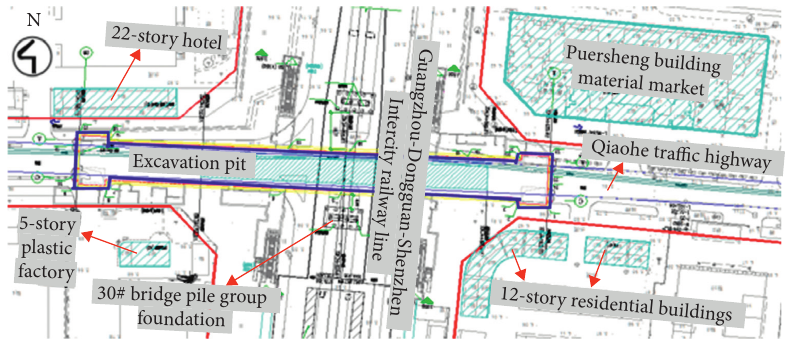
Figure 4: Plan view of the subway station project